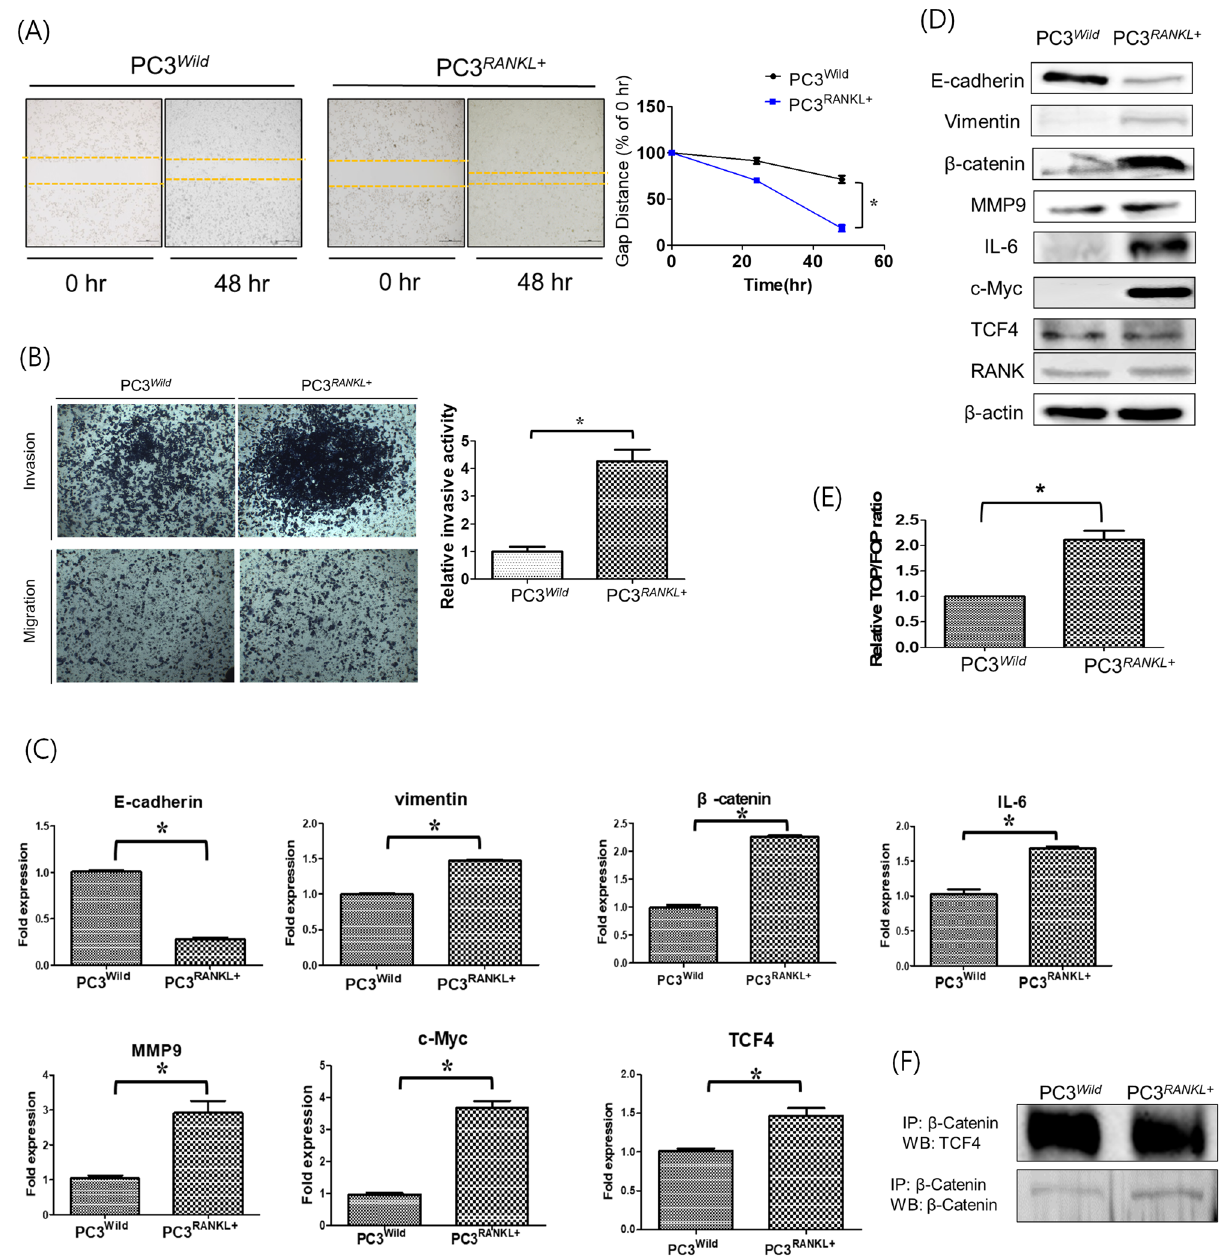
Figure 2. Modulation of the EMT and metastatic properties of PC3 cells following overexpression of RANKL. ( A ) A cell migration assay was performed to compare wound healing in PC3 Wild and PC3 RANKL+ cells. PC3 RANKL+ cells showed a significant increase in migratory capacity, as evident from the decreased wound gap at 48 h. Magnification, × 100; scale bar, 100 μm. The data in the associated graphs are expressed as the mean ± SD. ( B ) Transwell invasion assays were performed to compare the invasiveness of PC3 Wild and PC3 RANKL+ cells. PC3 RANKL+ cells showed a significant increase in invasiveness. Magnification, × 100; scale bar, 100 μm. Data in the associated graphs are expressed as the mean ± SD. ( C ) Real-time quantitative polymerase chain reaction for the analysis of EMT and metastasis markers in PC3 RANKL+ cells. β-Actin was used as a loading control. Significant differences were observed at *p < 0.05, compared with the control. ( D ) Expression of E-cadherin, Vimentin, β-catenin, MMP-9, IL-6 and β-actin in PC3 Wild and PC3 RANKL+ cells, as measured by western blotting. β-Actin was used as a loading control. ( E ) Immunoprecipitation for β-catenin and TCF-4 in PC3 Wild and PC3 RANKL+ cells. Each blot was obtained under the same experimental conditions and the data are representative of three separate experiments with comparable results. ( F ) TOP/FOP luciferase reporter assays in PC3 Wild and PC3 RANKL+ cells. Significant differences were observed at *p < 0.05, compared with the